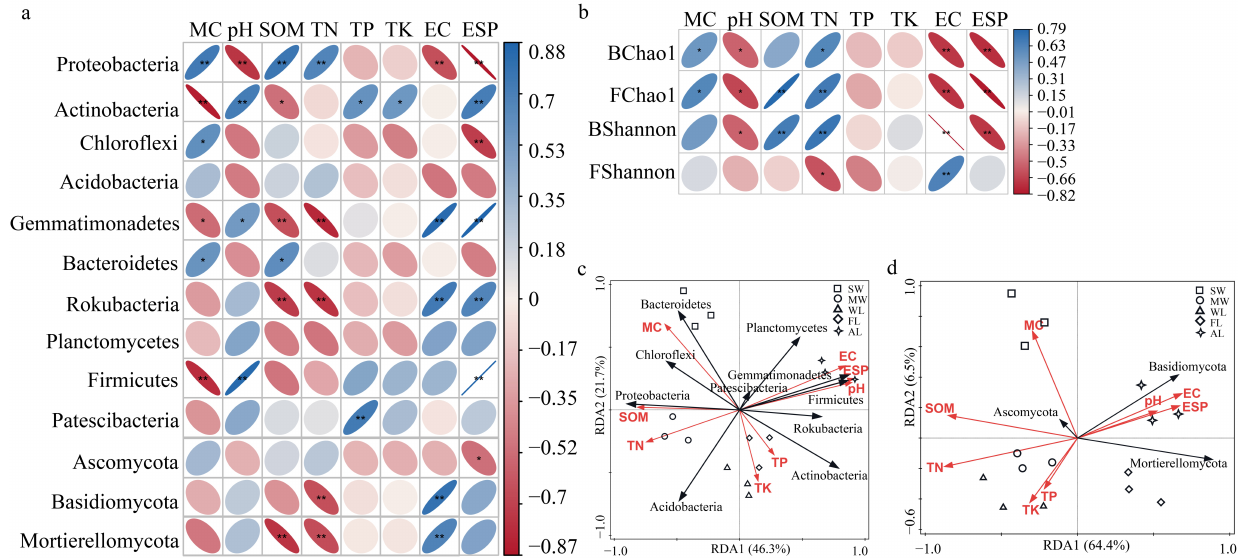
Figure 5. Spearman correlation analyses between soil characteristics and ( a ) dominant microbial phyla and ( b ) microbial community alpha diversity and redundancy analysis (RDA) on soil dominant ( c ) bacteria and ( d ) fungi at the phylum level constrained by soil characteristics variables. MC, moisture content; SOM, soil organic matter; TN, total nitrogen; TP, total phosphorus; TK, total kalium; ESP, exchange sodium percent. SW, swamp wetland; MW, meadow wetland; WL, woodland; FL, farmland; AL, alkaline land. * correlation significant at 0.05 level. ** correlation significant at 0.01